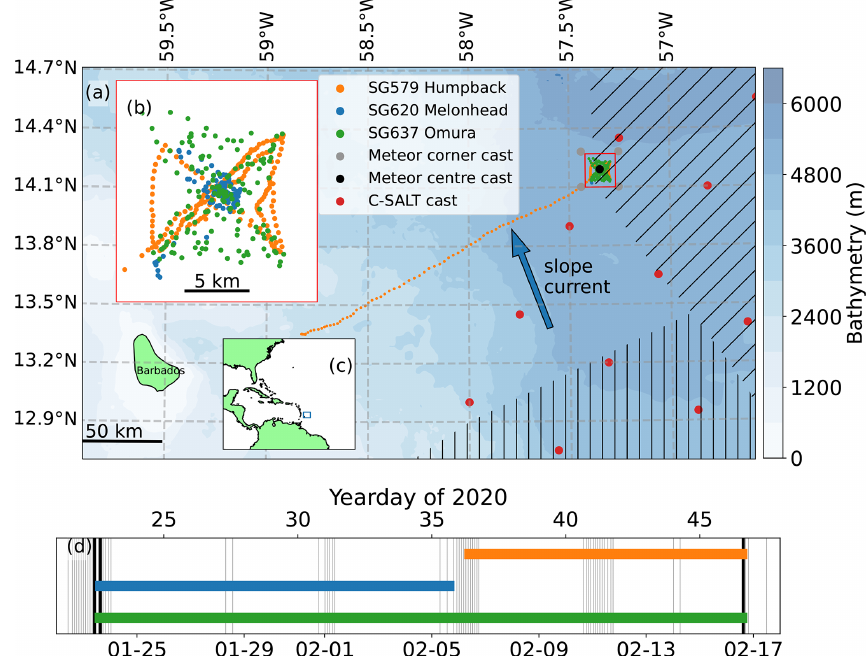
Figure 2. (a) Glider survey map showing glider and CTD data from the tropical North Atlantic. Red dots are CTD casts conducted during the C-SALT experiment in Spring 1985 (Schmitt, 1987). Diagonal and vertical hatching respectively delineate the approximate areas of strong and weak staircases identified by Schmitt et al. (1987). (b) Zoomed detail of bow tie outlined in red on (a) . (c) Map of the tropical North Atlantic; the blue box marks extent of (a) . (d) Temporal overlap of glider observations at the bow tie and nearby Meteor CTD casts. Meteor corner casts were taken at grey dots on map. Meteor centre casts were taken at the black dot. Colours match legend in (a) . The orange line for SG579 in this subplot covers only the period during which it was at the bow